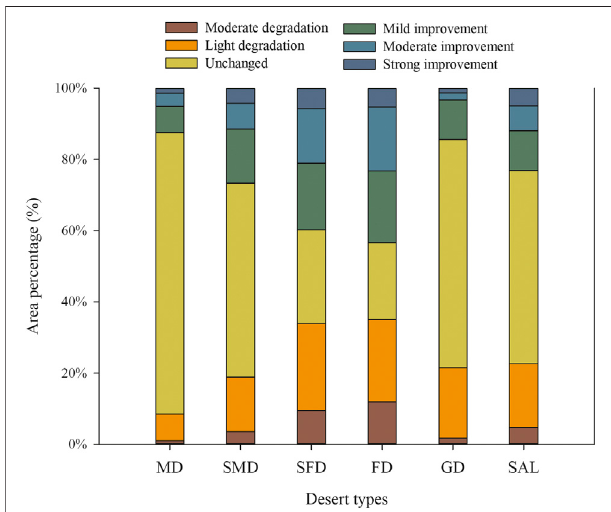
FIGURE 6 | Proportions of the area of each of the six desert types that showed changes in the normalized-difference vegetation index (NDVI) from 1998 to 2015. Desert types: MD, mobile dunes; SMD, semi-mobile dunes; SFD, semi- fi xed dunes; FD, fi xed dunes; GD, gobi desert; SAL, saline – alkali